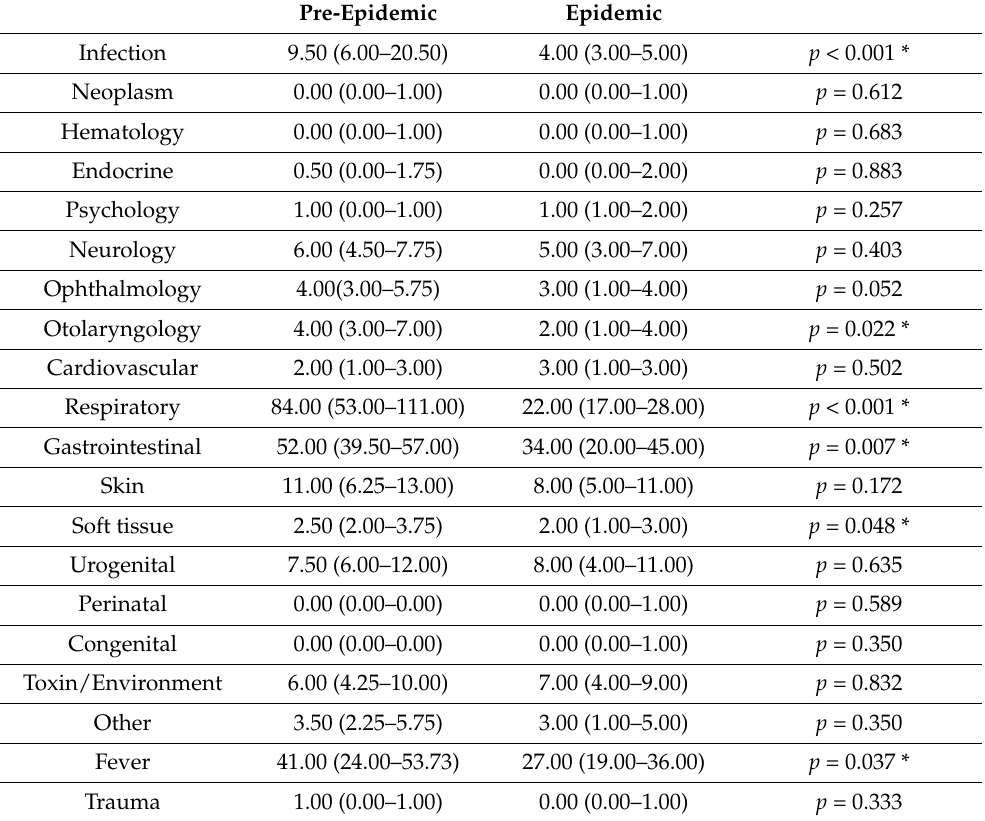
Table 2. Average patient number classified by organ systems in EM residents’ month rotation.